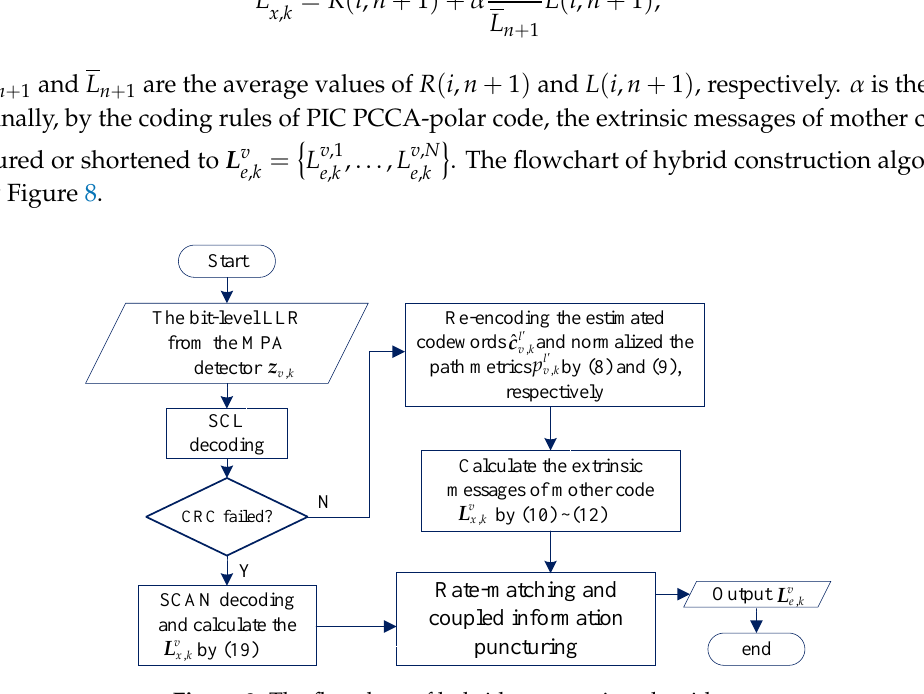
Figure 8. The flowchart of hybrid construction algorithm.